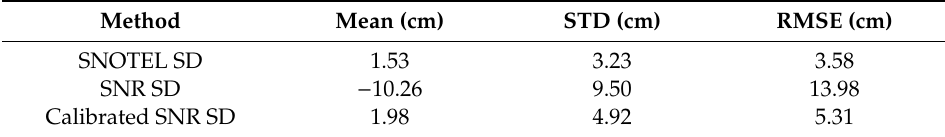
Figure 13. Scatterplot of the SNOTEL SWE estimates versus SNOTEL SD-based, SNR SD-based and calibrated SNR SD-based SWE estimates ( left ); scatterplot of SNOTEL SD-based observations versus SNR SD-based estimates in three periods and calibrated SNR SD-based estimates ( right ). Table 6. Mean, STD and RMS of errors for SNOTEL SD-based, SNR SD-based, and calibrated SNR SD-based SWE estimation.